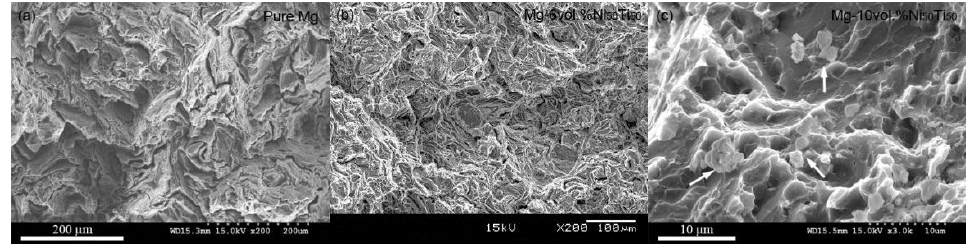
Figure 17. Representative tensile fractographs showing typical cleavage mode fracture in: ( a ) pure Mg and ( b ) Mg-6 vol% Ni 50 Ti 50 and ( c ) prominent particle segregation in Mg-10 vol% Ni 50 Ti 50. White arrows represent fine amorphous particles. (reprinted